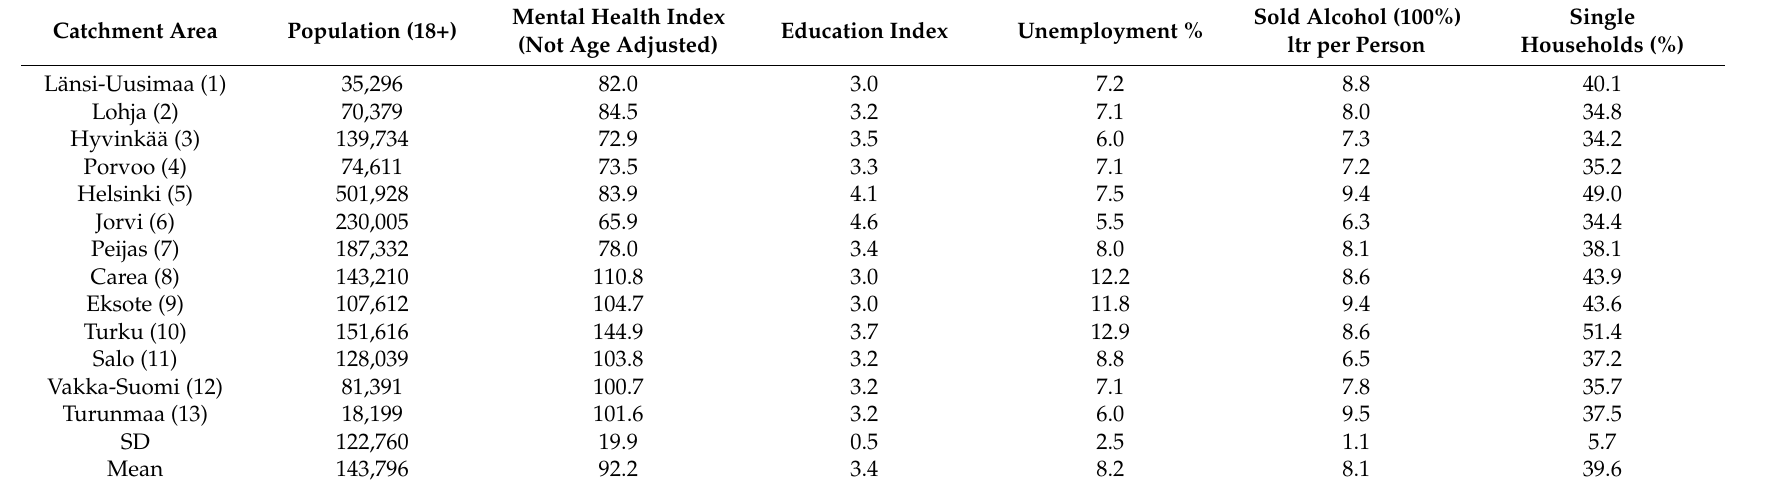
Table 3. Socioeconomic factors and population mental health status.